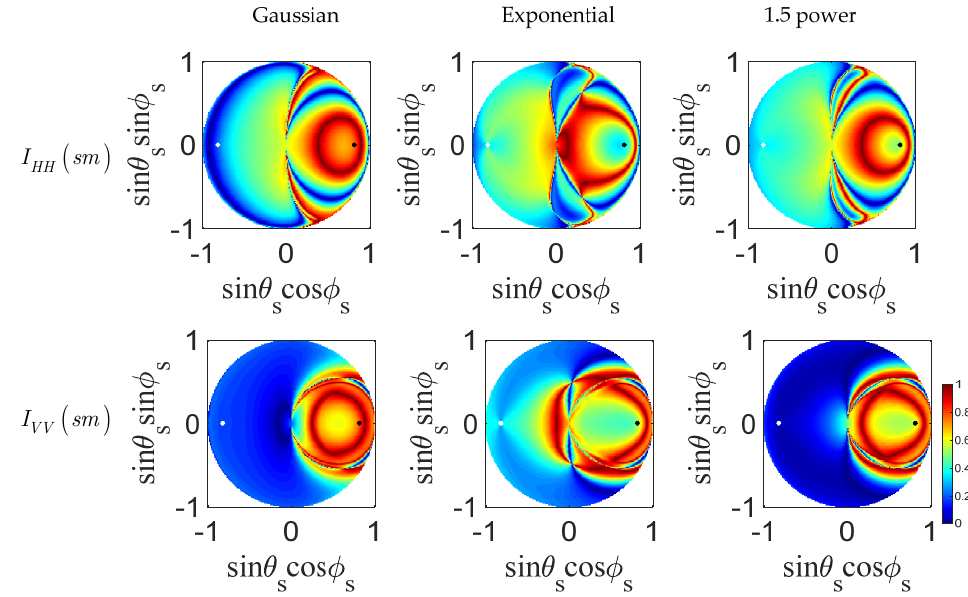
Figure 6. Patterns of the single-co-polarized ( HH or VV ) quality index to soil moisture obtained at Ku band, θ i = 55 ◦ and kl = 6.3 .